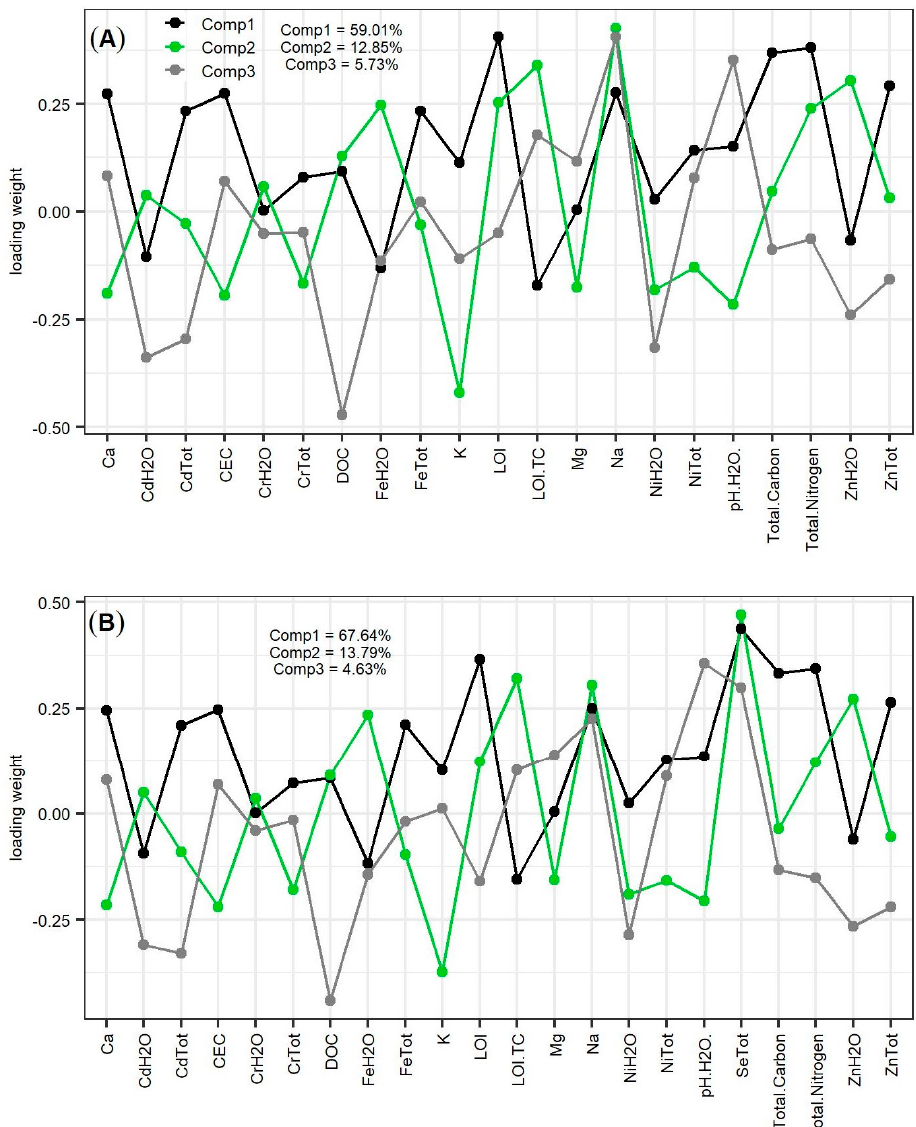
Figure 6. Loading weights from the calibrated PLS model (3 components, Figure 5) for Se H2O, including soil properties and concentrations of other elements ( A ) and Se Tot ( B ).